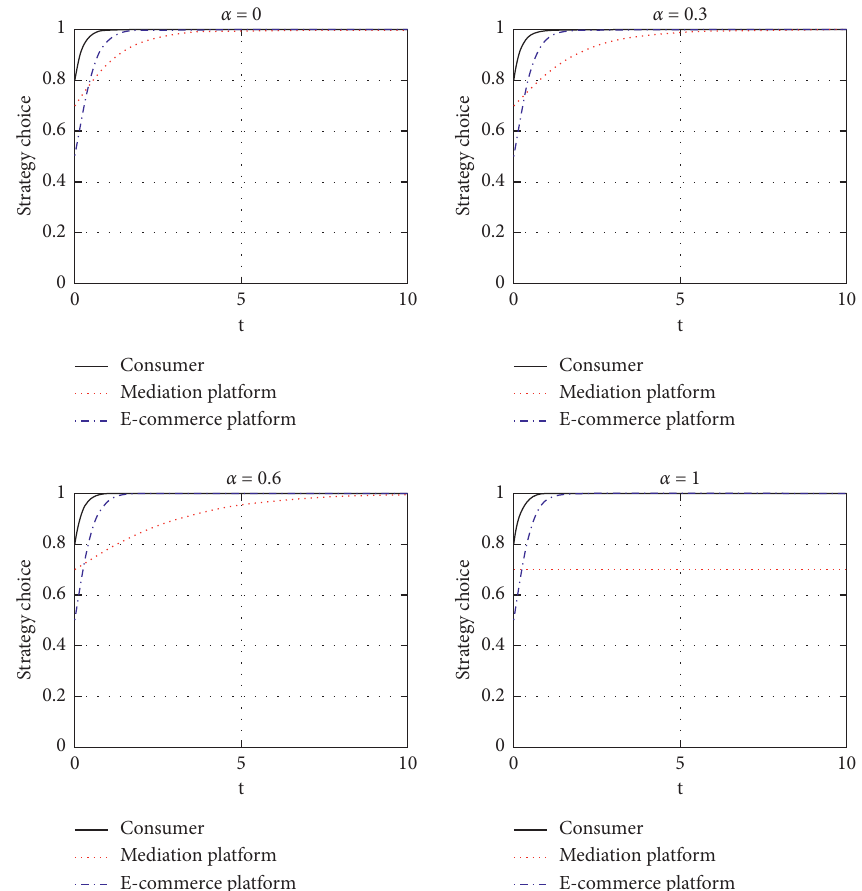
Figure 5: Influence of the probability of the e-commerce platform being enrolled in the mediation